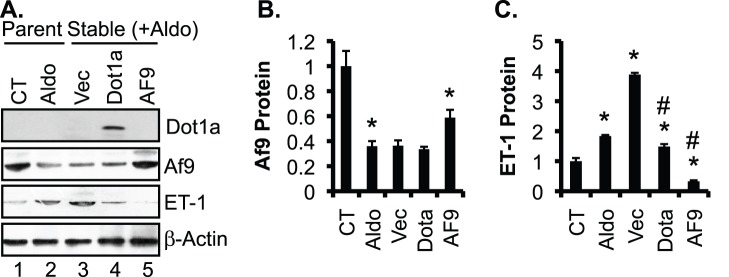
Overexpression of Dot1a and Af9 reverses aldosterone-induced ET-1 expression in NRK-52E cells. NRK-52E cells were treated with vehicle as control (CT), or treated with 50 nM aldosterone (Aldo) for 24 h, and were analyzed in parallel with stably transfected NRK-52E cell lines. These cell lines had integrated pcDNA3.1 as vector control (Vec), or its derivatives expressing untagged mouse Dot1a (Dot1a) or Af9 (Af9) and were treated with 50 nM aldosterone (Aldo) for 24 h. (A) Representative IBs showing expression of Dot1a, Af9, and ET-1, with β-actin as internal control. Note, the anti-Dot1a antibody detected the overexpressed mouse Dot1a, but apparently not the endogenous rat Dot1a, possibly due to its poor reactivity with rat Dot1a, low level of rat Dot1a, or both. (B–C) The intensity of each band was analyzed as in Fig. 5E–F. n = 3–6. In all cases, *P<0.05 vs. CT. #P<0.05 vs. Vec.